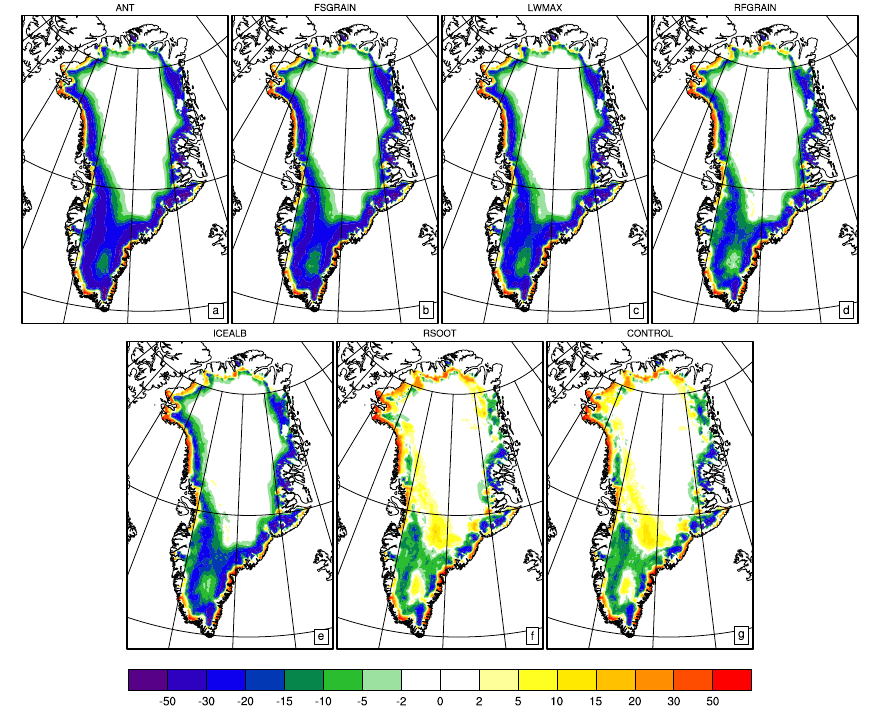
Fig. 8. Difference in number of melt days between the RACMO2 experiments and the SSM/I observations (Fig. 7) for the period May to August 2007. The individual simulations are listed in Table 1 and explained in the text. The last column in Table 2 lists the average melt area for the period May to August